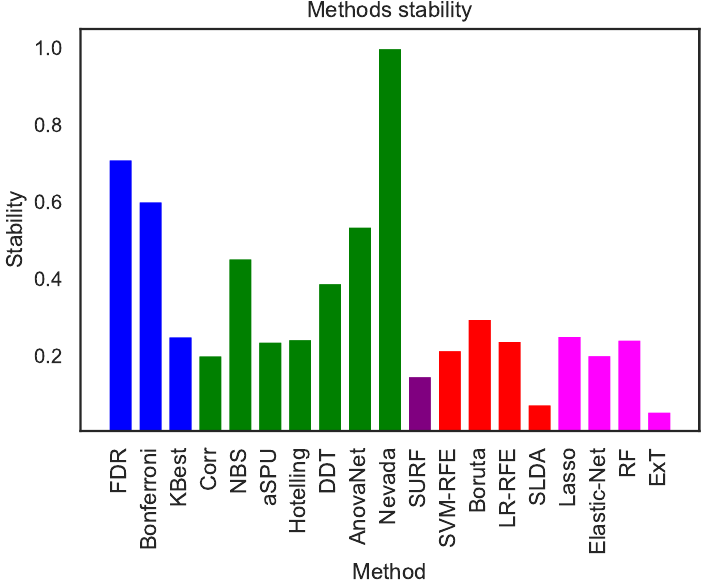
Figure 5. Intra-stability D of each method, representing how consistently each method is yield- ing the same link selection over random subsamples of the original dataset. See Equation (3) for a definition of the metric D